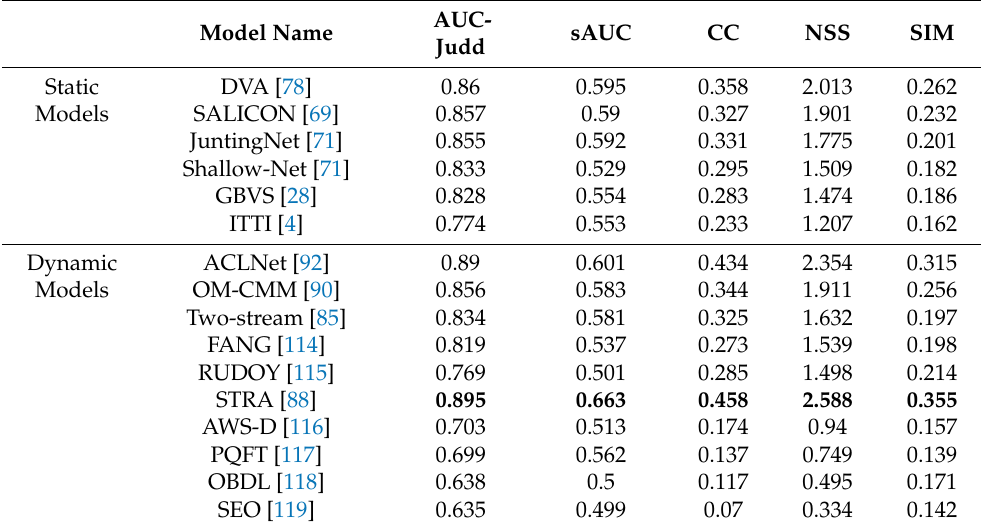
Table 4. Performance of the dynamic models over the DHF1K